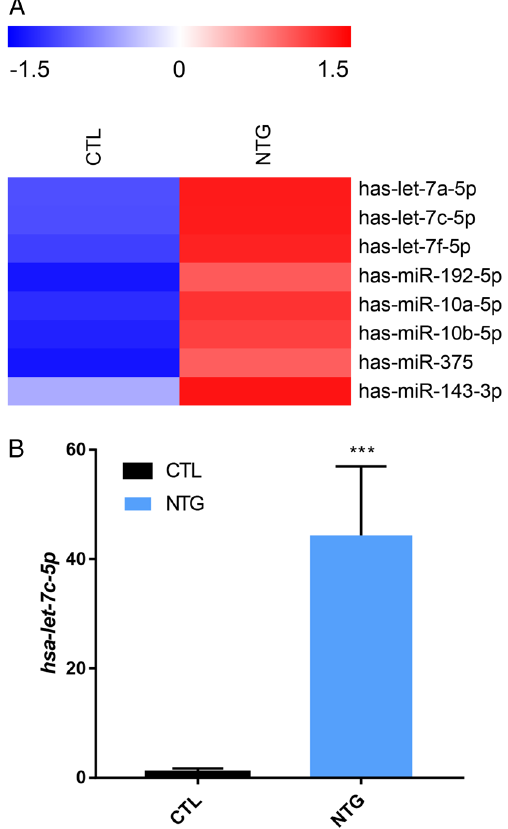
Figure 2. Quantitative PCR validation of miRNA in AH of NTG patients compared with control. ( A ) The heatmap diagram demonstrated the results of RNA sequencing by expression of miRNAs. Red represents high relative expression and blue represents low relative expression (Z-score). Data was presented by ExDEGA v1.2.1.0 software. ( B ) hsa-let-7c-5p expression in the AH of NTG patients by quantitative PCR validation analysis. The expression of let-7c-5p increased significantly in the AH of the NTG patients compared to control (44.32 ± 3.63-fold, p < 0.001). Data are represented as the mean ± S.E.M. and were analyzed using Unpaired Student’s t-test (n = 7). *** p < 0.001 versus Control. AH aqueous humor, NTG normal tension glaucoma, S.E.M . standard error of the